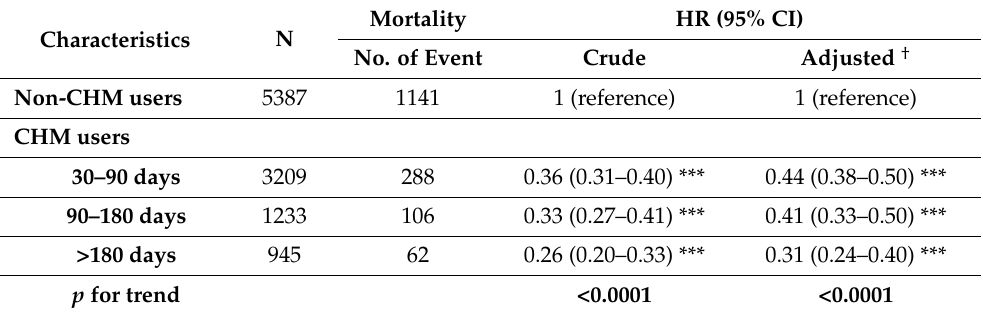
Table 3. The risk of mortality rate stratified by the cumulative days of CHM use among breast cancer patients.